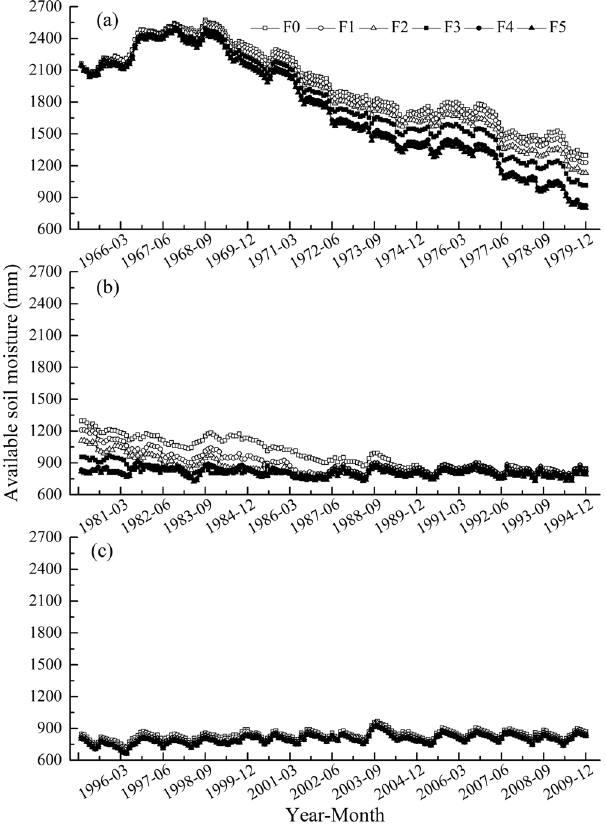
Figure 3. Simulated monthly available soil moisture in the 0–15 m soil level under different fertilization treatments in the apple orchards of